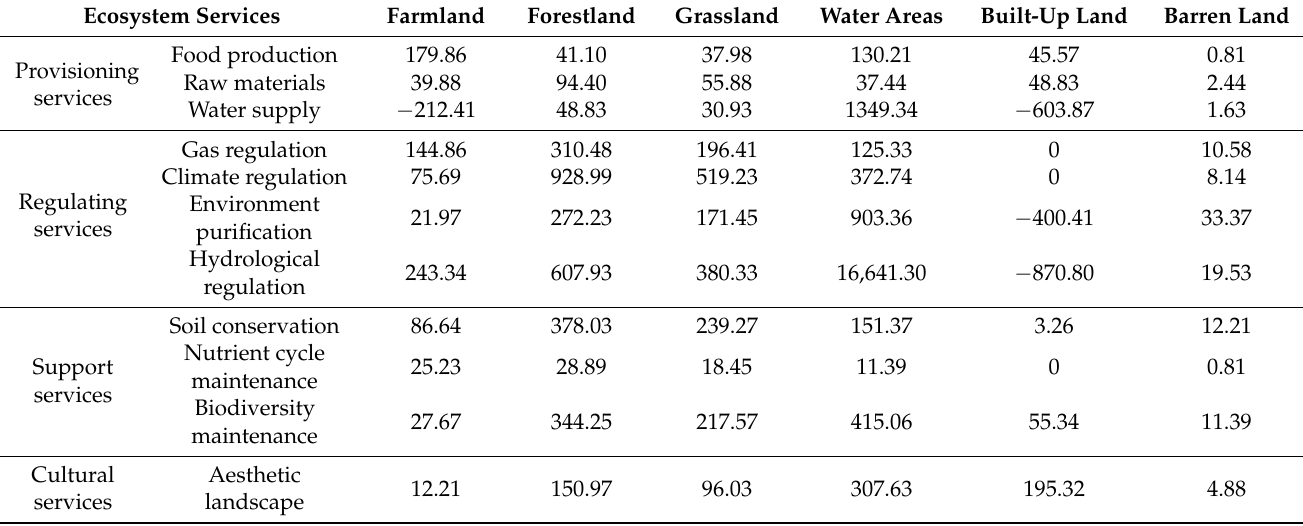
Table 1. Value coefficients of land ecosystem services in Shaanxi Province (USD ha − 1